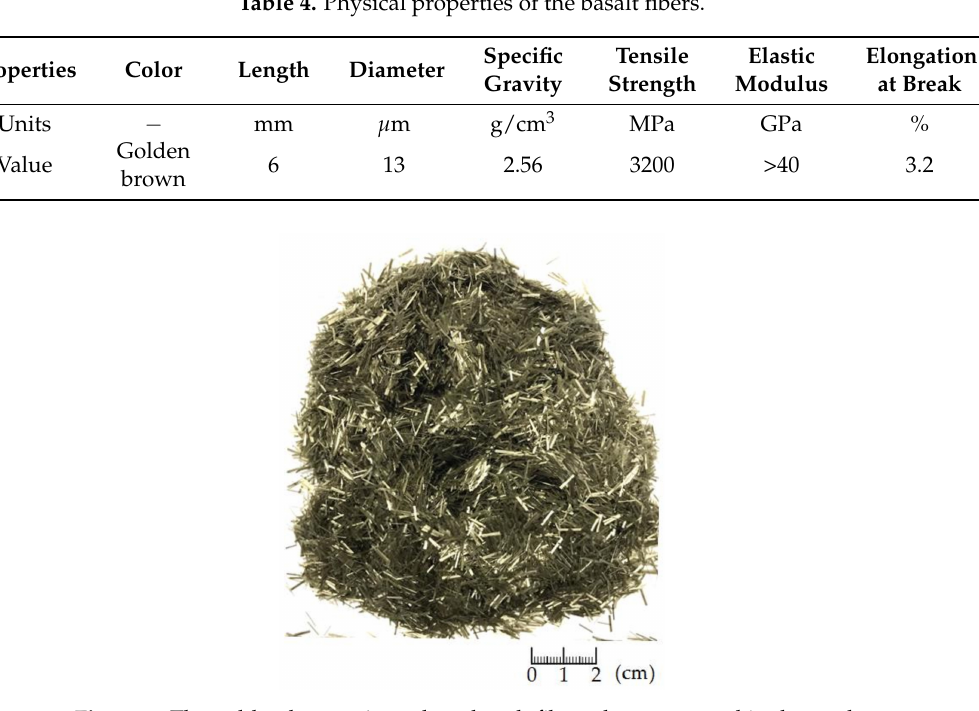
Figure 1. The golden-brown 6 mm long basalt fibers that were used in the